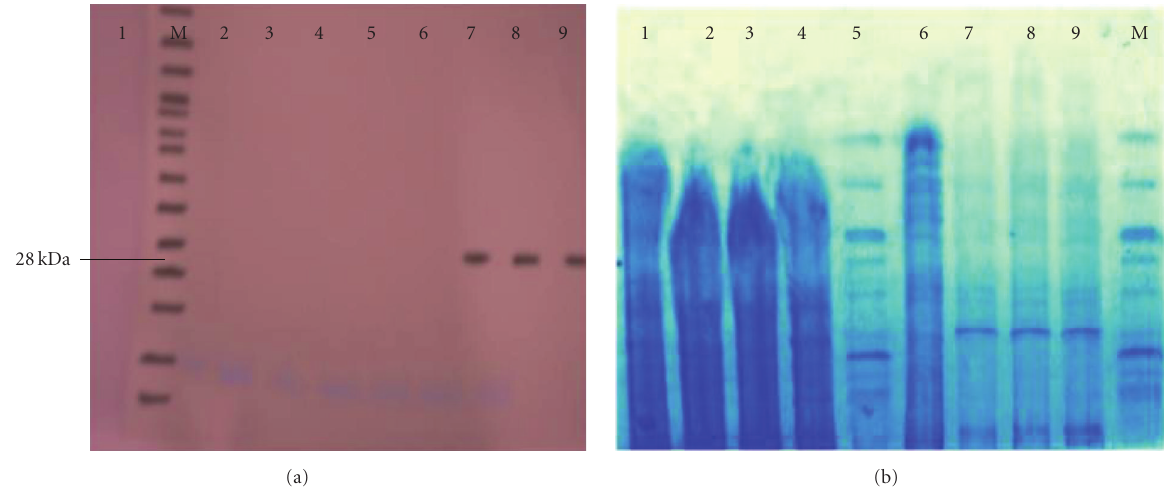
Figure 3: (a) Western blot analysis showing the expressed NS1 recombinant protein of ∼ 28 kDa in expressed GS115 Pichia pastoris strain using NS1 polyclonal antibody as a primary antibody; expression started at day 7 after methanol induction; (b) SDS-PAGE separating the proteins into di ff erent molecular weight prior to transfer to NC membrane and immunodetection.